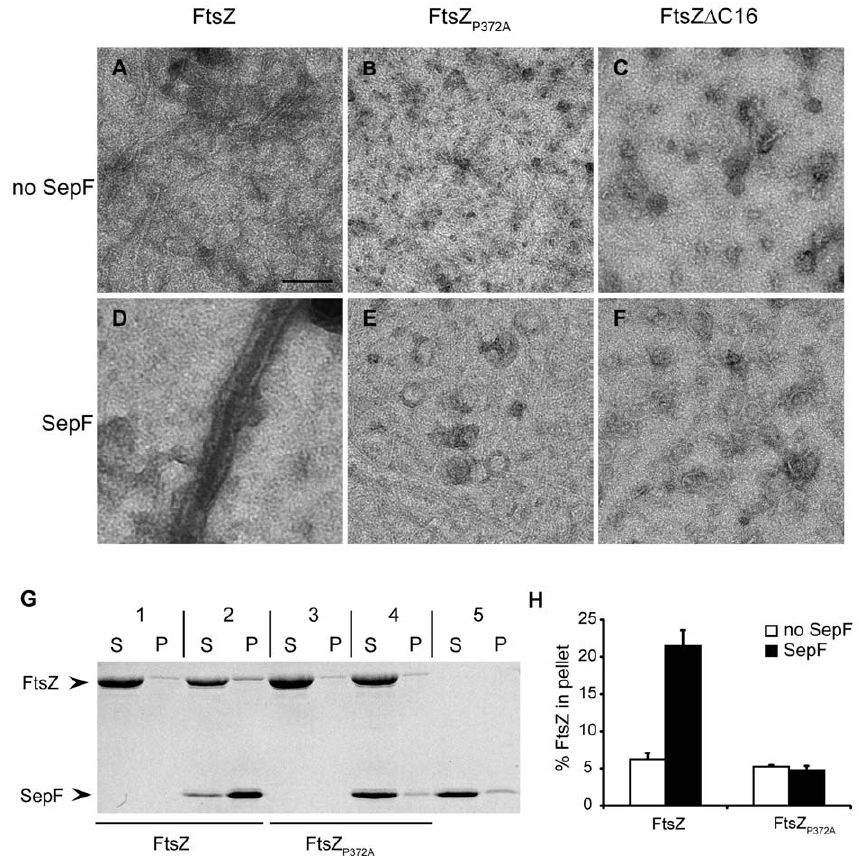
Figure 3. SepF cannot tubulate FtsZ D C16 and FtsZ P372A polymers. (A–F) Electron microscopy of 10 m M FtsZ (A, D), FtsZ P372A (B, E) and FtsZ D C16 (C, F) polymerized with 2 mM GTP in the absence (A–C) or presence (D–F) of 6 m M SepF. Scale bar: 100 nm. (G) Pelleting of FtsZ-SepF tubules by centrifugation. 10 m M FtsZ (1, 2) or FtsZ P372A (3,4) was polymerized with 2 mM GTP in the absence (1,3) or presence (2,4) of 12 m M SepF. As a control, SepF was used without FtsZ (5). Tubules were recovered by centrifugation and supernatant and pellet fractions were analyzed by SDS- PAGE. (H) Quantification of the amount of FtsZ pelleted in the assay shown in (G). Three independent experiments were analyzed, error bars indicate standard deviation.